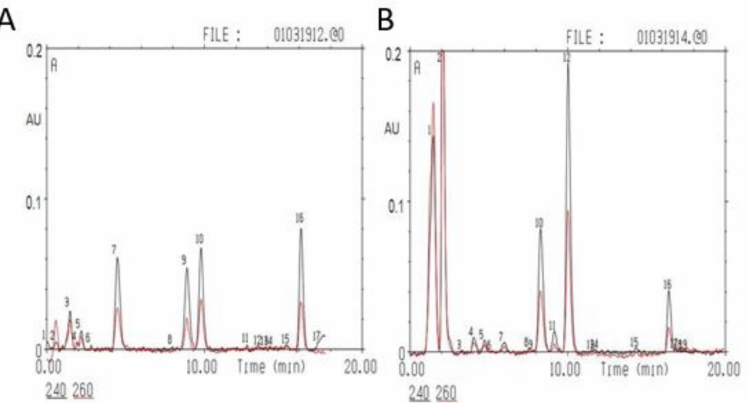
Figure 9. Steroid analysis . Chromatographic separation of a mixture of standards: ( A ). 7– aldosterone, 911-dehydroCORT, 10–CORT, and 16–desoxyCORT (C = 10 ng/ µ L, 5 µ L was taken for the analysis); and adrenal extracts ( B ). 5–aldosterone, 11–11-dehydroCORT, 12–CORT, and 16– desoxyCORT. The black line corresponds to absorption at 240 nm, the red line to absorption at 260 nm. The y-axis represents absorption (A) in absorption units (AU); the x-axis shows time in